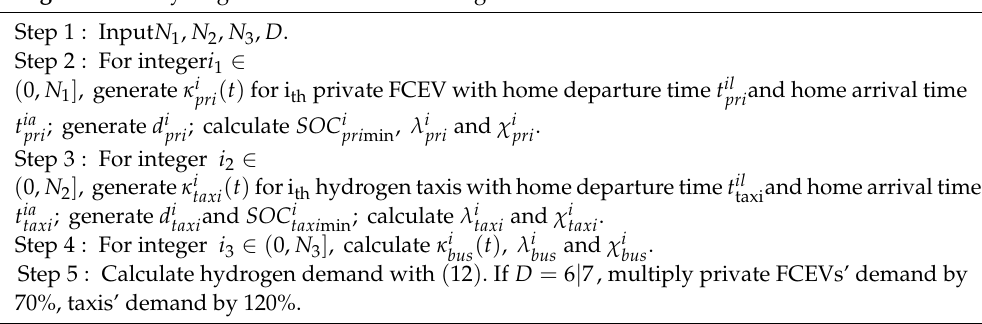
Algorithm 1. Hydrogen demand estimation